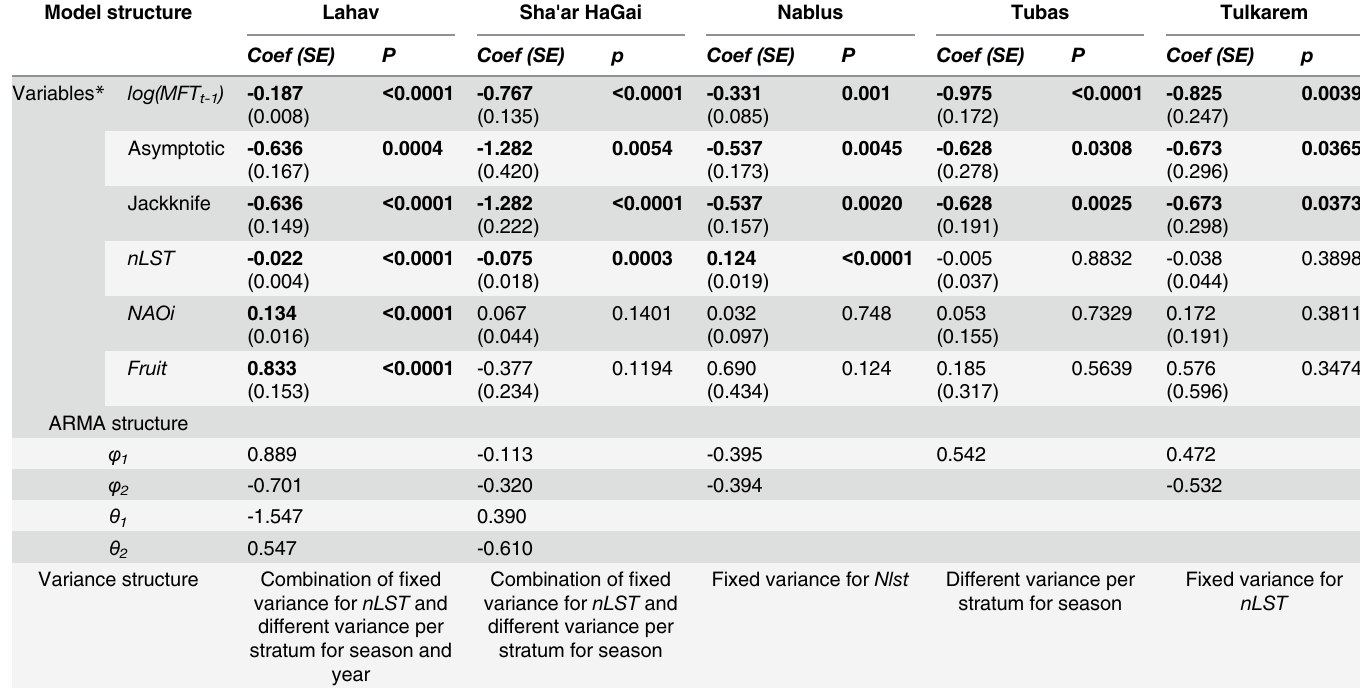
Table 2. Summary of selected generalized-least-squares models of the rate of change ( R t ) in Bactrocera oleae populations in five locations in the Eastern Mediterranean region. Model structure